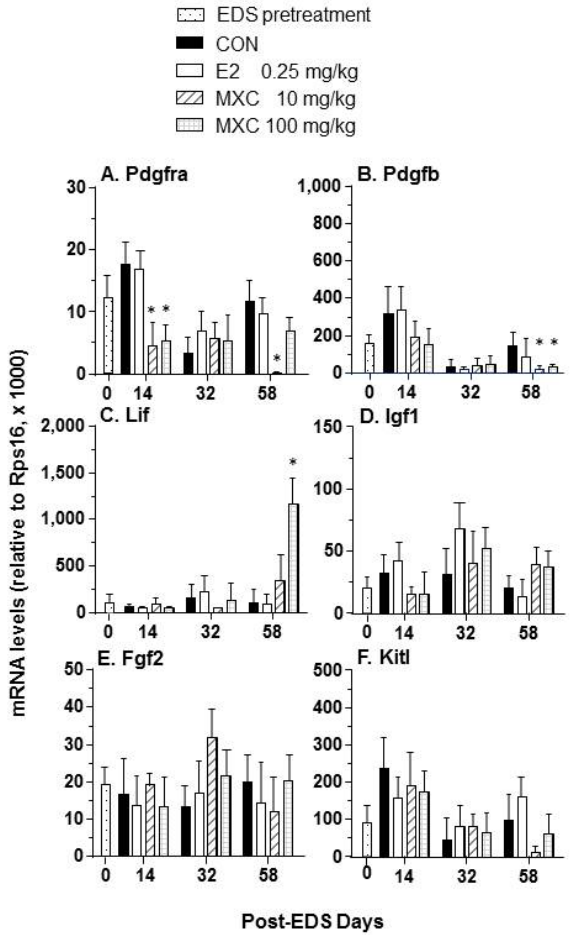
Figure 5. Quantitative PCR assay of the growth factor/receptor gene expression levels of the testis. ( A ) Pdgfra ; ( B ) Pdgfb ; ( C ) Lif ; ( D ) Igf1 ; ( E ) Fgf2 ; ( F ) Kitl . Mean ± SEM, n = 5. * indicates significant difference when compared to the control (CON) at each time point at p <